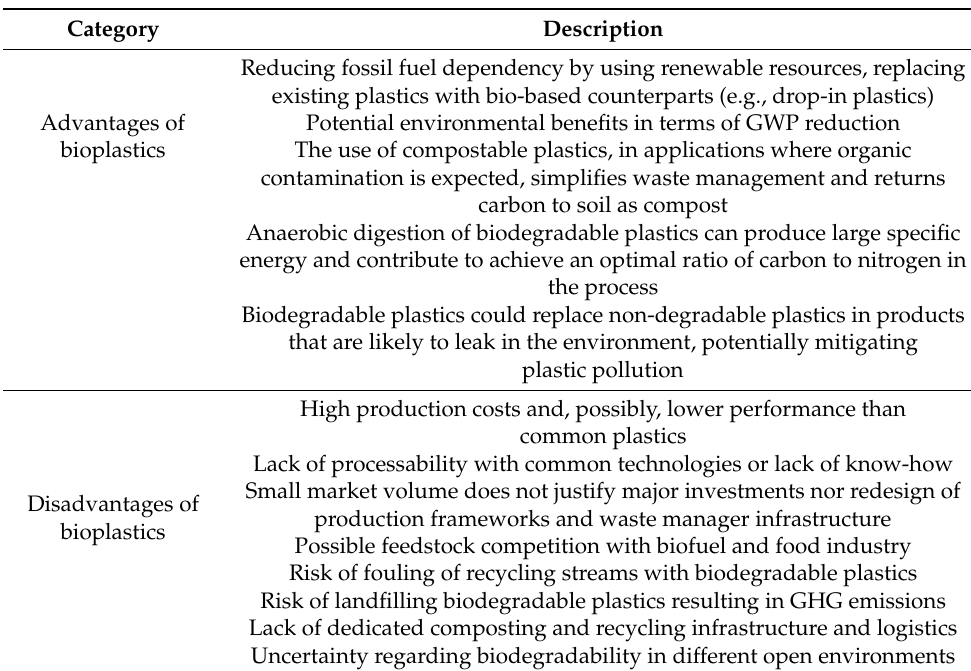
Table 6. Summary of potential advantages and disadvantages related to the adoption of